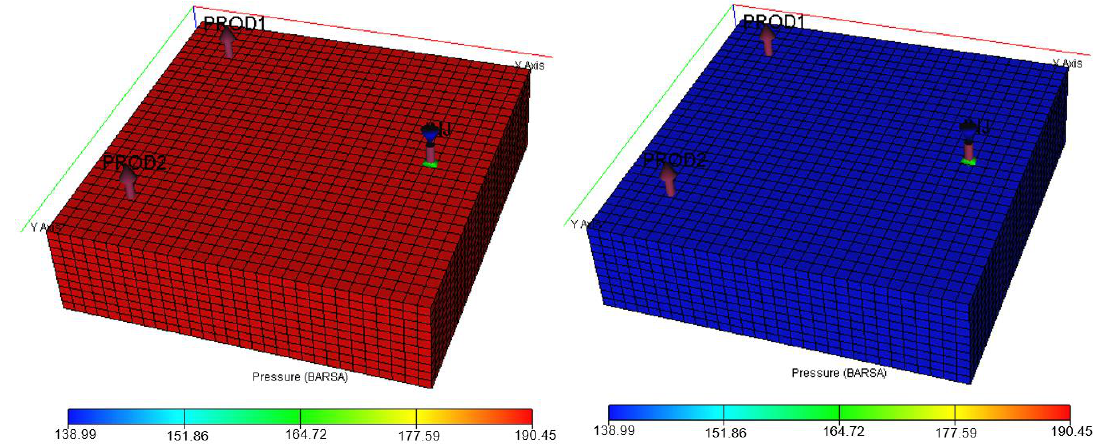
Figure 16. 3D field pressure ( a ) before simulation and ( b ) after simulation of 1840 days.